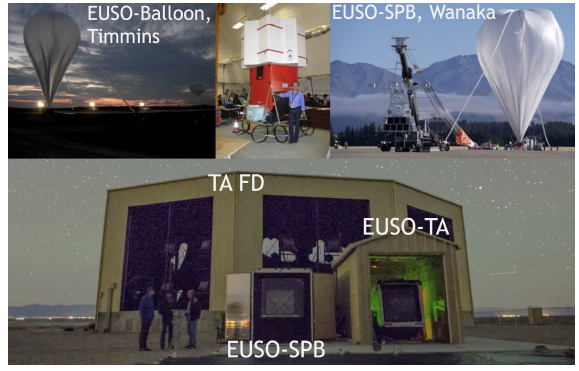
Figure 1. EUSO-TA and stratospheric balloon missions of the JEM-EUSO program. See text for